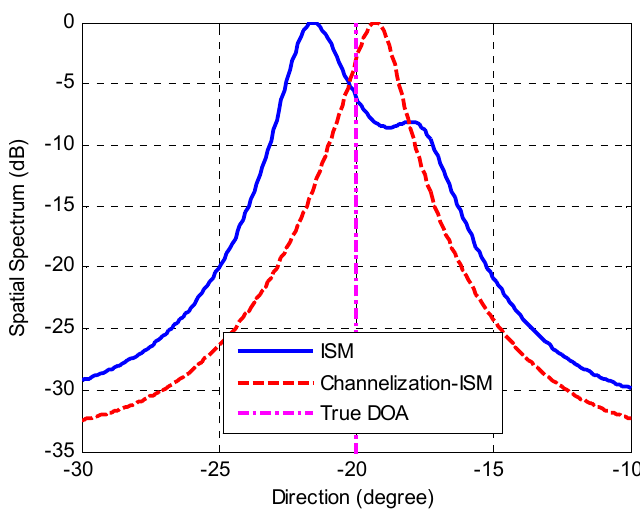
Figure 20. DOA estimations with ISM method and Channelization-ISM method. Figure 19. DOA estimations with ISM method and Channelization-ISM method. Figure 19. DOA estimations with ISM method and Channelization-ISM method.